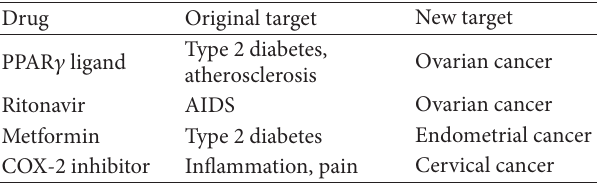
Table 1: Drug repositioning for treatment of gynecologic